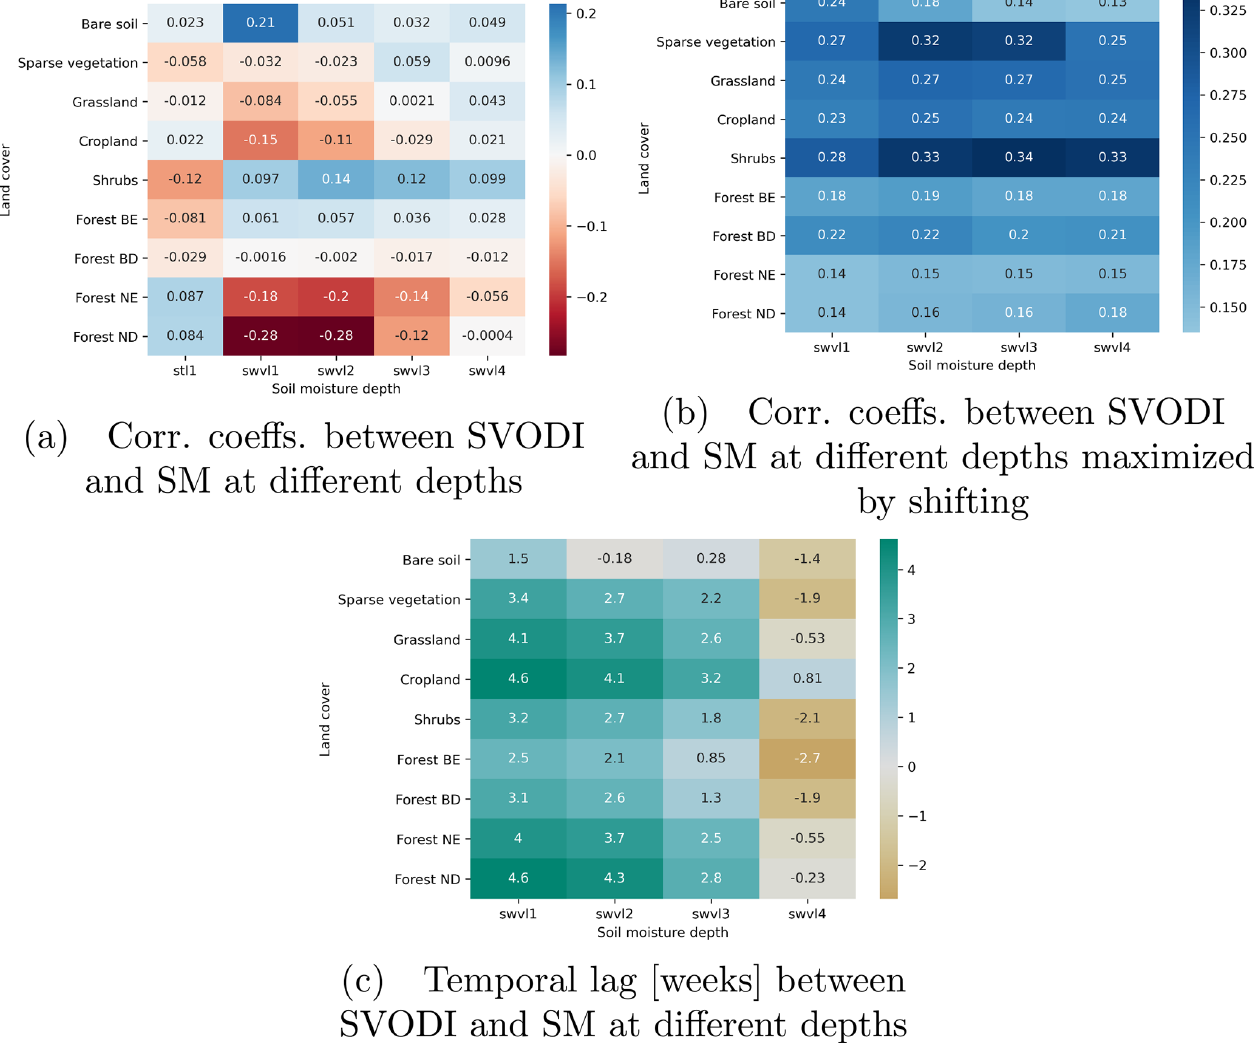
Figure 9. Mean correlation coefficient if no temporal shifting is done (a) , maximum correlation obtained by temporal shifting (b) and the corresponding temporal shift in weeks between SVODI and soil moisture anomalies (c) at different ERA5 depths. The depths are swvl1 0–7, swvl2 7–28, swvl3 28–100 and swvl4 100–289cm. Panel (a) also shows the correlation with the surface soil temperature,